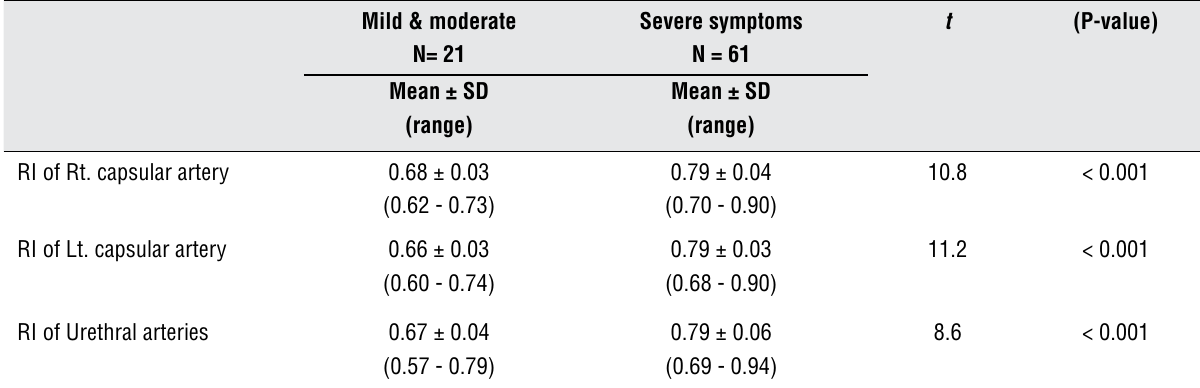
Table 3 - Comparison of the RI of Rt & Lt capsular arteries and urethral arteries between patients with mild to moderate symptoms, and with severe symptoms according to IPSS.